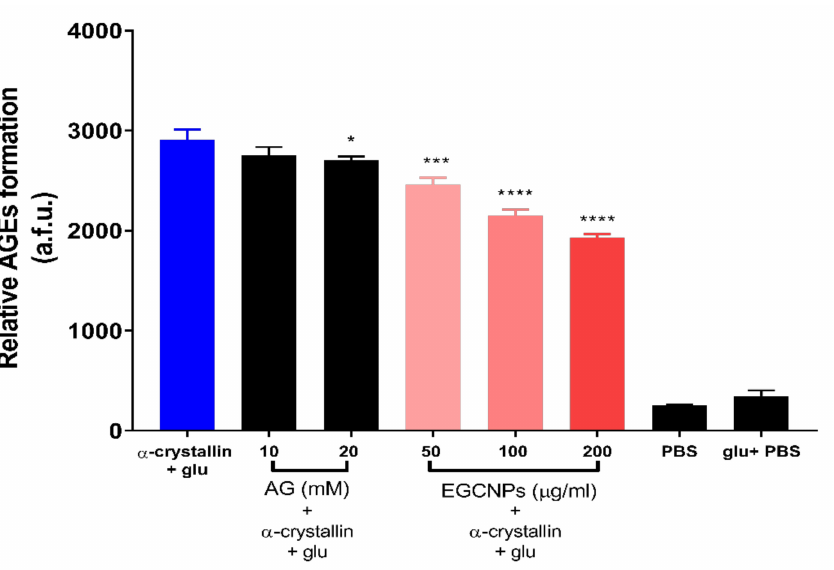
Figure 6. Effect of EGCNPs on the inhibition of the formation of advanced glycation end products (AGEs) for bovine α -crystallin when incubated with glucose (glu) for 72 h. For comparison, two con- centrations of aminoguanidine (AG) were used as it is known for its antiglycation actions. Formation of AGEs was measured by spectrofluorometry using a plate reader at ex/em = 300/400 nm. Asterisks denote statistical significance from BSA + glu, ( n = 3, * p ≤ 0.01, *** p ≤ 0.001 and **** p ≤ 0.0001, one-way ANOVA). Error bars are presented as means ±